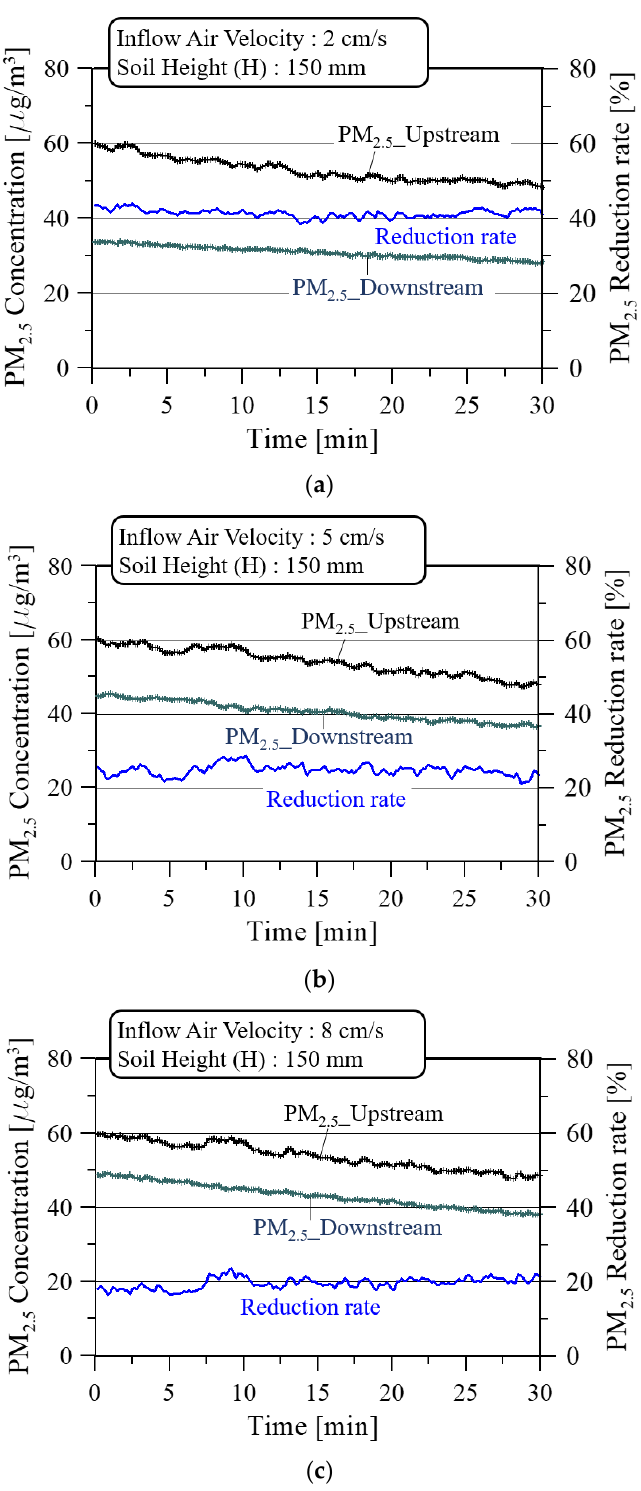
Figure 11. PM 2.5 concentrations and reduction rate at the soil height (H) of 150 mm and the soil moisture of 35 ± 5% for three inflow air velocities: ( a ) 2 cm/s; ( b ) 5 cm/s; and ( c ) 8 cm/s.